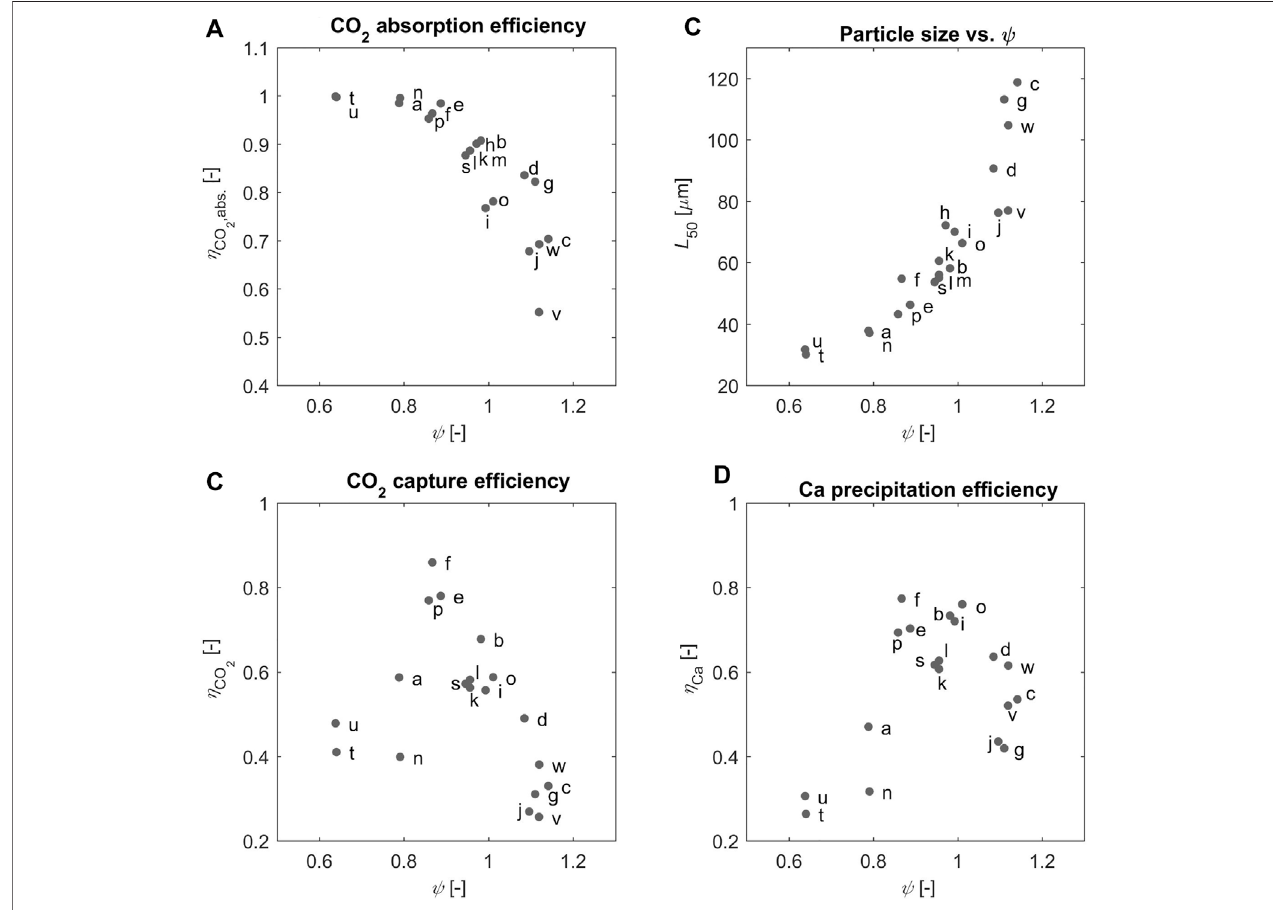
FIGURE 6 | (A) The absorption ef fi ciency (B) the L 50 , (C) the CO 2 capture ef fi ciency and (D) the calcium precipitation ef fi ciency is plotted over ψ .